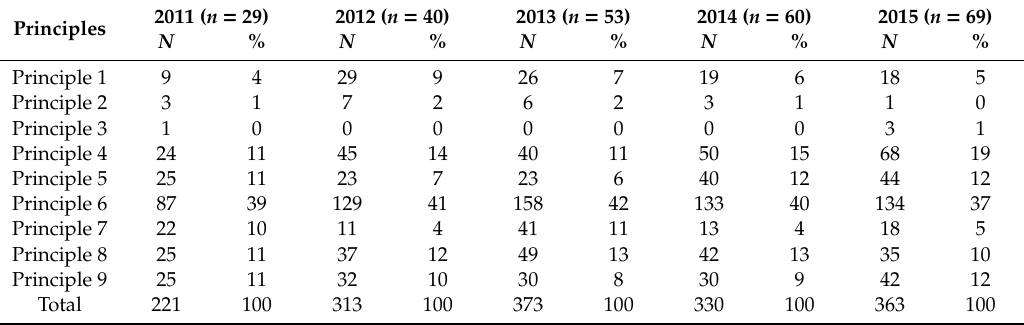
Table 4. Frequencies of minor non-conformities (NCs) in NW Russia for 2011–2015.